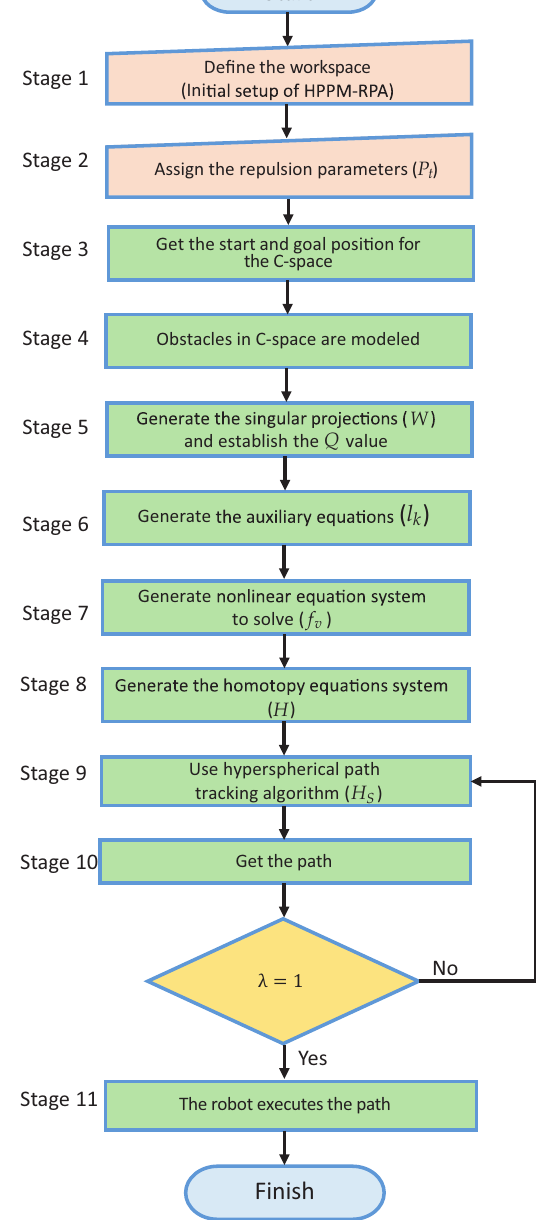
Figure 8. HPPM-PRA method